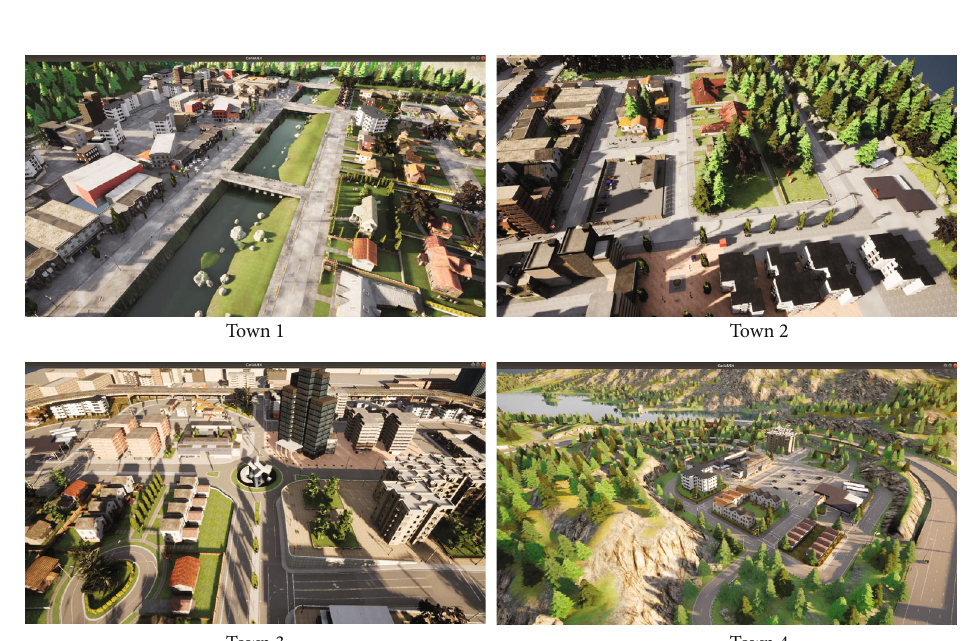
Figure 4: Four di ff erent towns of